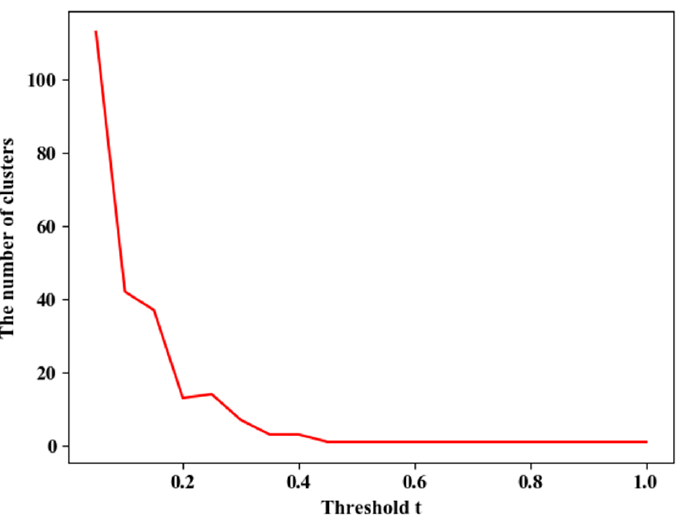
Figure 13. Variation of the number of categories K with the threshold t under each connection method.